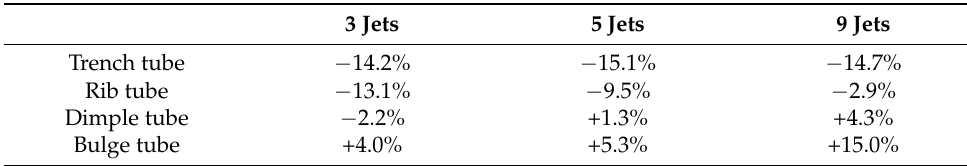
Table 3. Area-averaged Nusselt number for a structured tube compared with a smooth tube with different jets at Re D = 50,000.